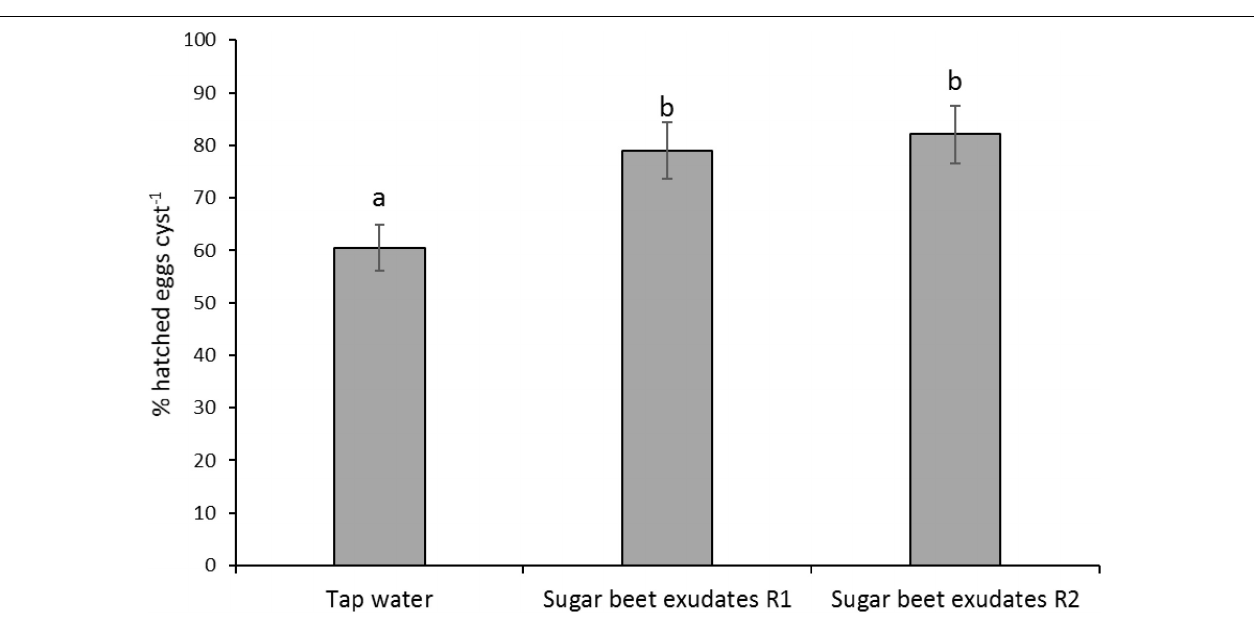
FIGURE 5 | Hatching of Heterodera schachtii at 4 cm soil depth following application of 15 or 30 ml root exudates of sugar beet from top soil at 100% concentration at 2 (R1) or 4 (R2) days intervals, respectively, as compared with tap water as controls. Different lowercase letters above the error bars represent significant differences between treatments according to Tukey test (5% significance